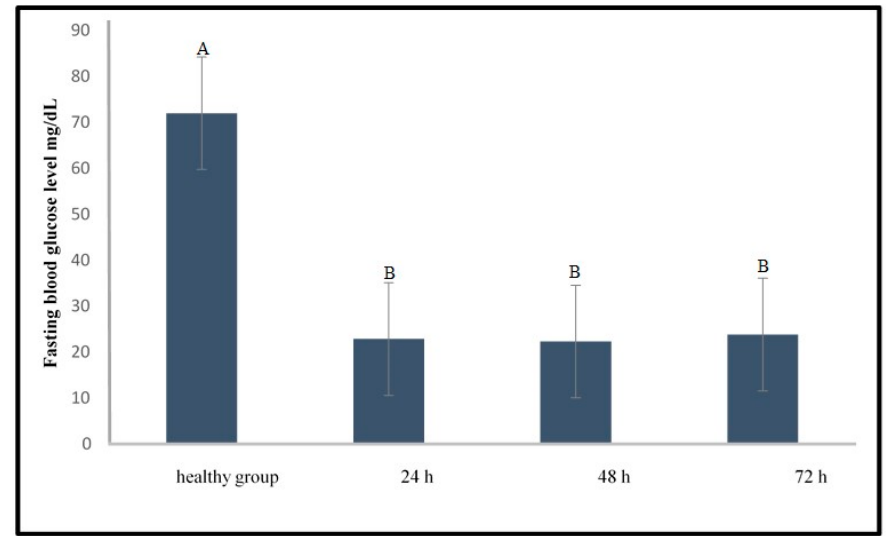
Figure 1. Fasting blood glucose level of healthy and streptozotocin (STZ) treated zebrafish in different timeline following the protocol of Intin et al. [12]. Different capital letter indicates significant difference ( p < 0.05) among the values, n = 10.